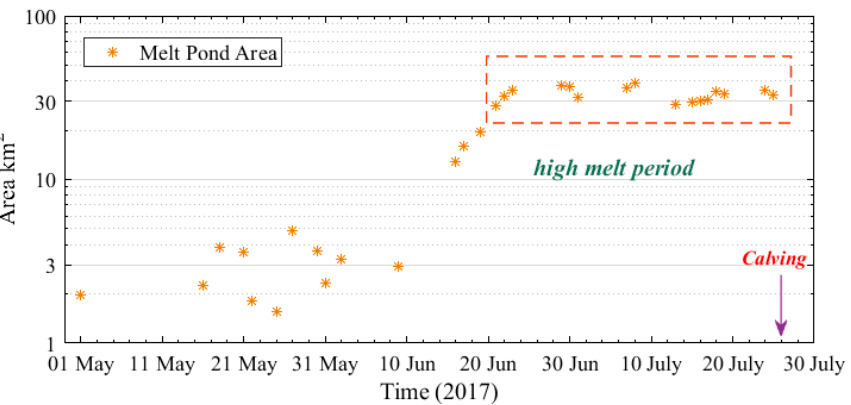
Figure 10. The time series of the Petermann glacier melt ponds’ area in the floating ice region prior to the calving event of July 2017.